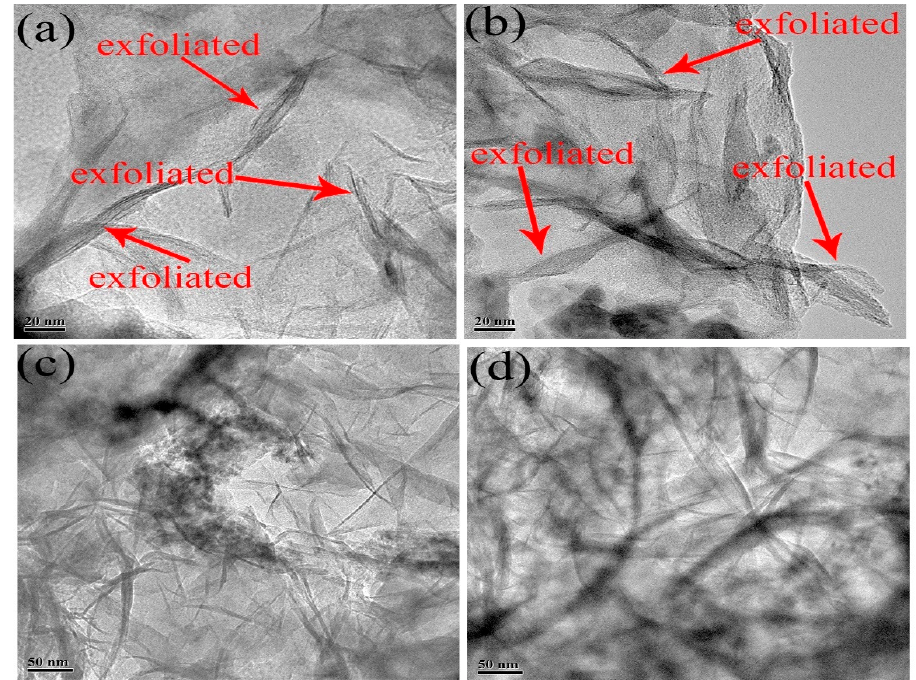
Figure 8. TEM images of ( a – d ) well-exfoliated and well-dispersed ASD/1.0 wt% O-MMt. Various parts of the samples showed different nanolayer thicknesses. The O-MMt nanolayers appear as dark lines in the TEM micrographs, in which several exfoliated O-MMt nanolayers are observed, as shown in Figure 8a,b. The red arrows in the images indicate dispersions of exfoliated O-MMt nanolayers. Numerous single O-MMt layers are observed in Figure 8c,d. The exfoliated nanolayers were uniformly distributed in the poly- mer matrix and exerted a significant nano-effect on the performance of the ASD/1.0 wt% O-MMt nanocomposite. The TEM images of ASD, ASD/0.5 wt% O-MMt, and ASD/2.0 wt% O-MMt are presented in Figure